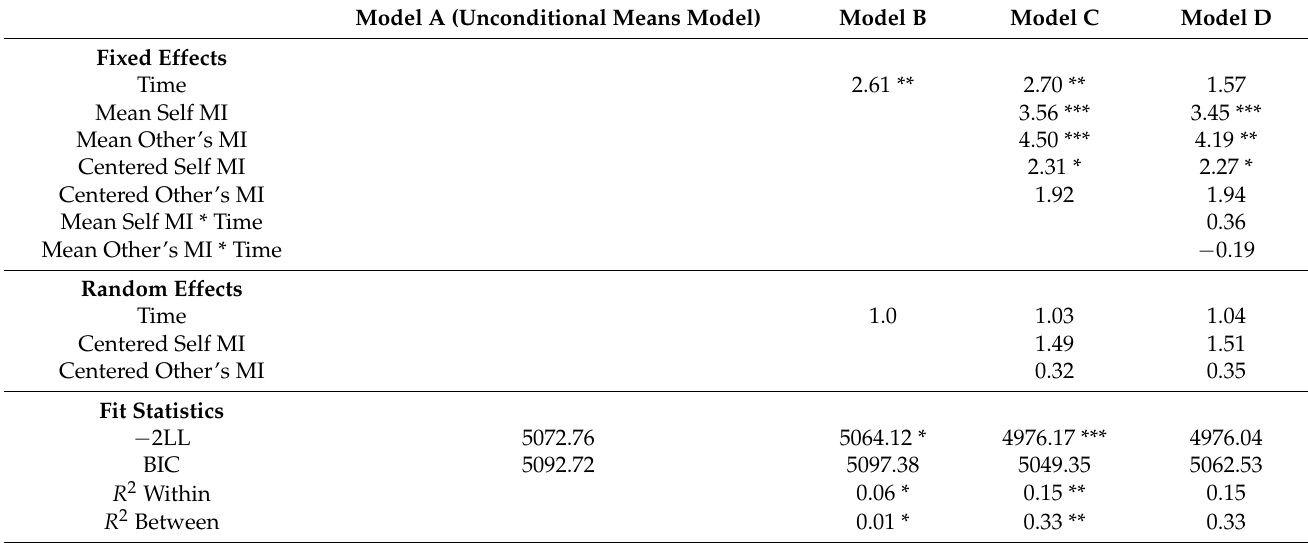
Table 5. Results of multi-level modeling predicting burnout from moral